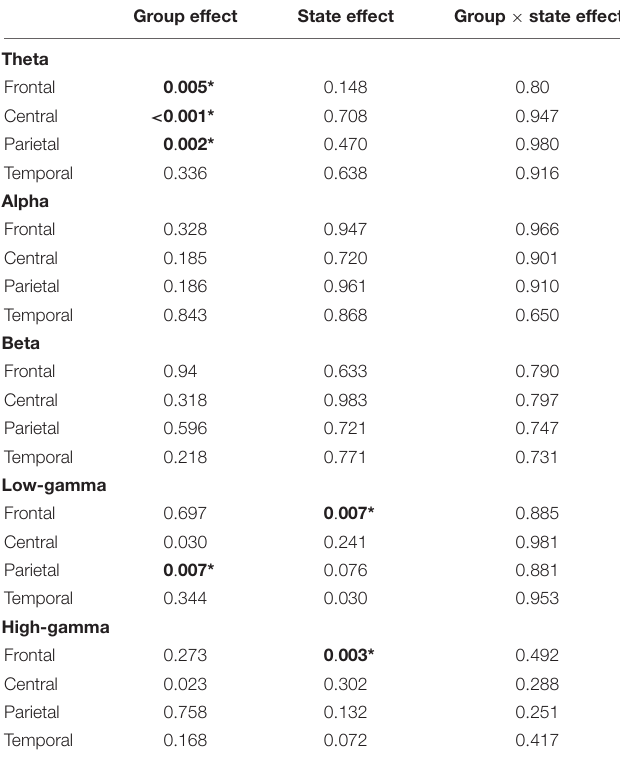
*Significance difference after Bonferroni correction for multiple